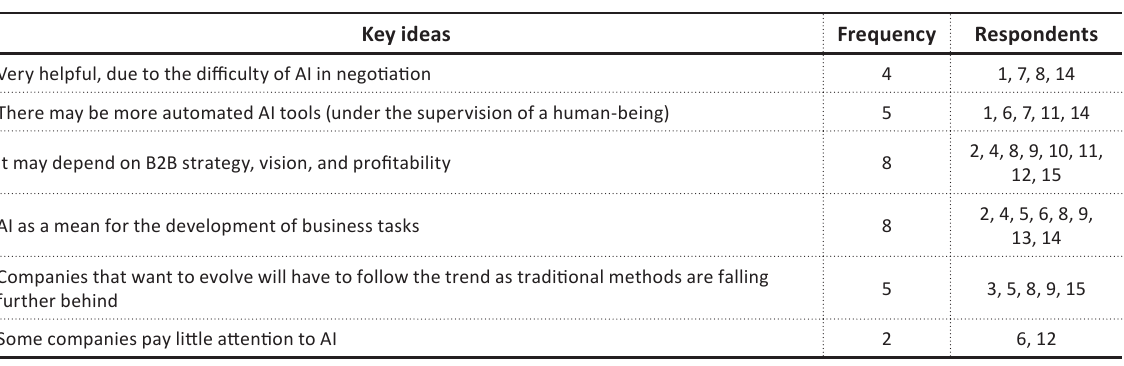
Table 4. Companies perspective, according to commercials, about the future impact of AI tools on